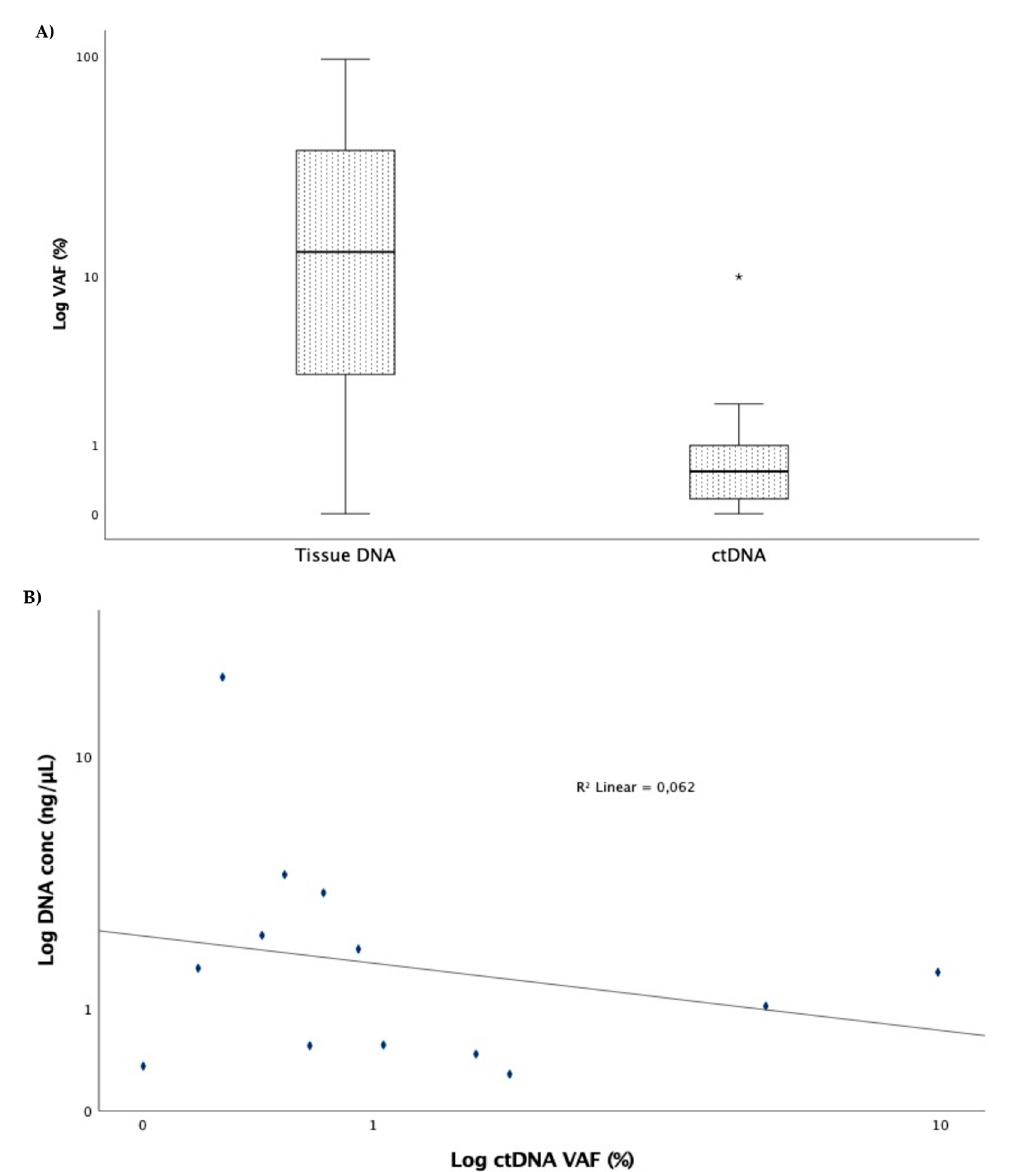
Figure 1. ( A ) Variant allelic fraction between tissue and ctDNA at baseline. Box represents the interquartile range of values and whiskers the median and the 25th and 75th percentile values (* p < 0.001, Mann–Whitney test). ( B ) Correlation between ctDNA concentration and variant allelic fraction ( r = − 0.319; p = 0.289).